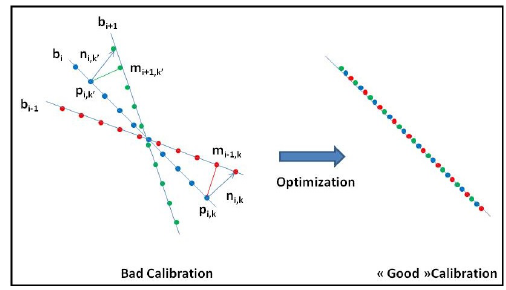
Figure 2. Side-view of a planar